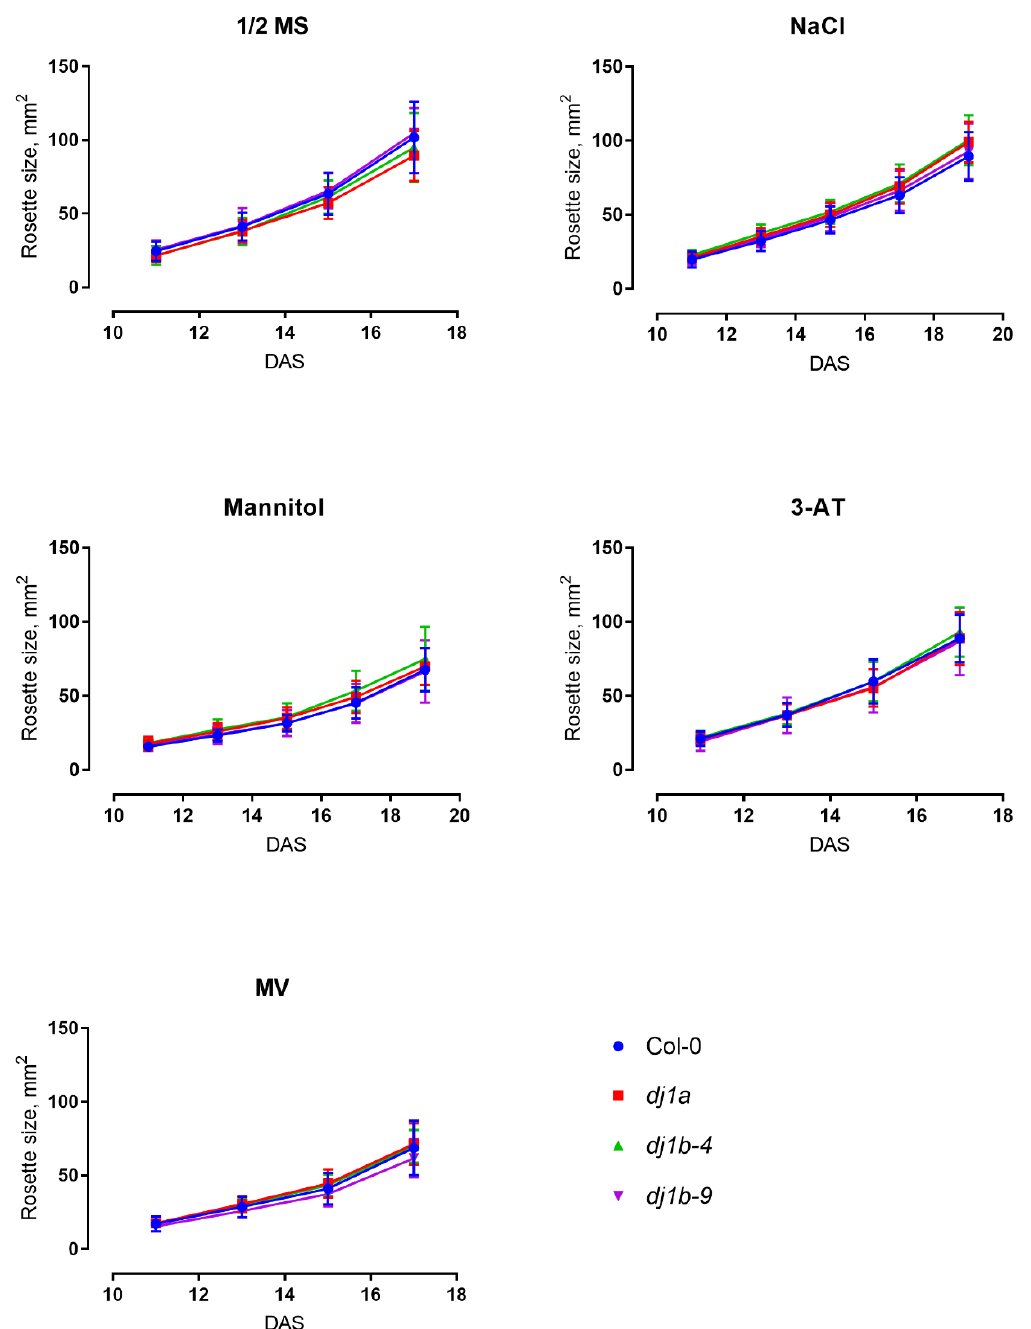
Figure 7. T-DNA insertion lines lacking AtDJ-1A or AtDJ-1B have no growth defects when subjected to various stresses. The plants were grown on 1 / 2 MS medium with stress-triggering additives: NaCl, mannitol, 3-amino-1,2,4-triazole (3-AT) or methyl viologen (MV) and their rosette sizes were analysed from bright-light images using ImageJ Software. Data points represent biological replicates ± SD.